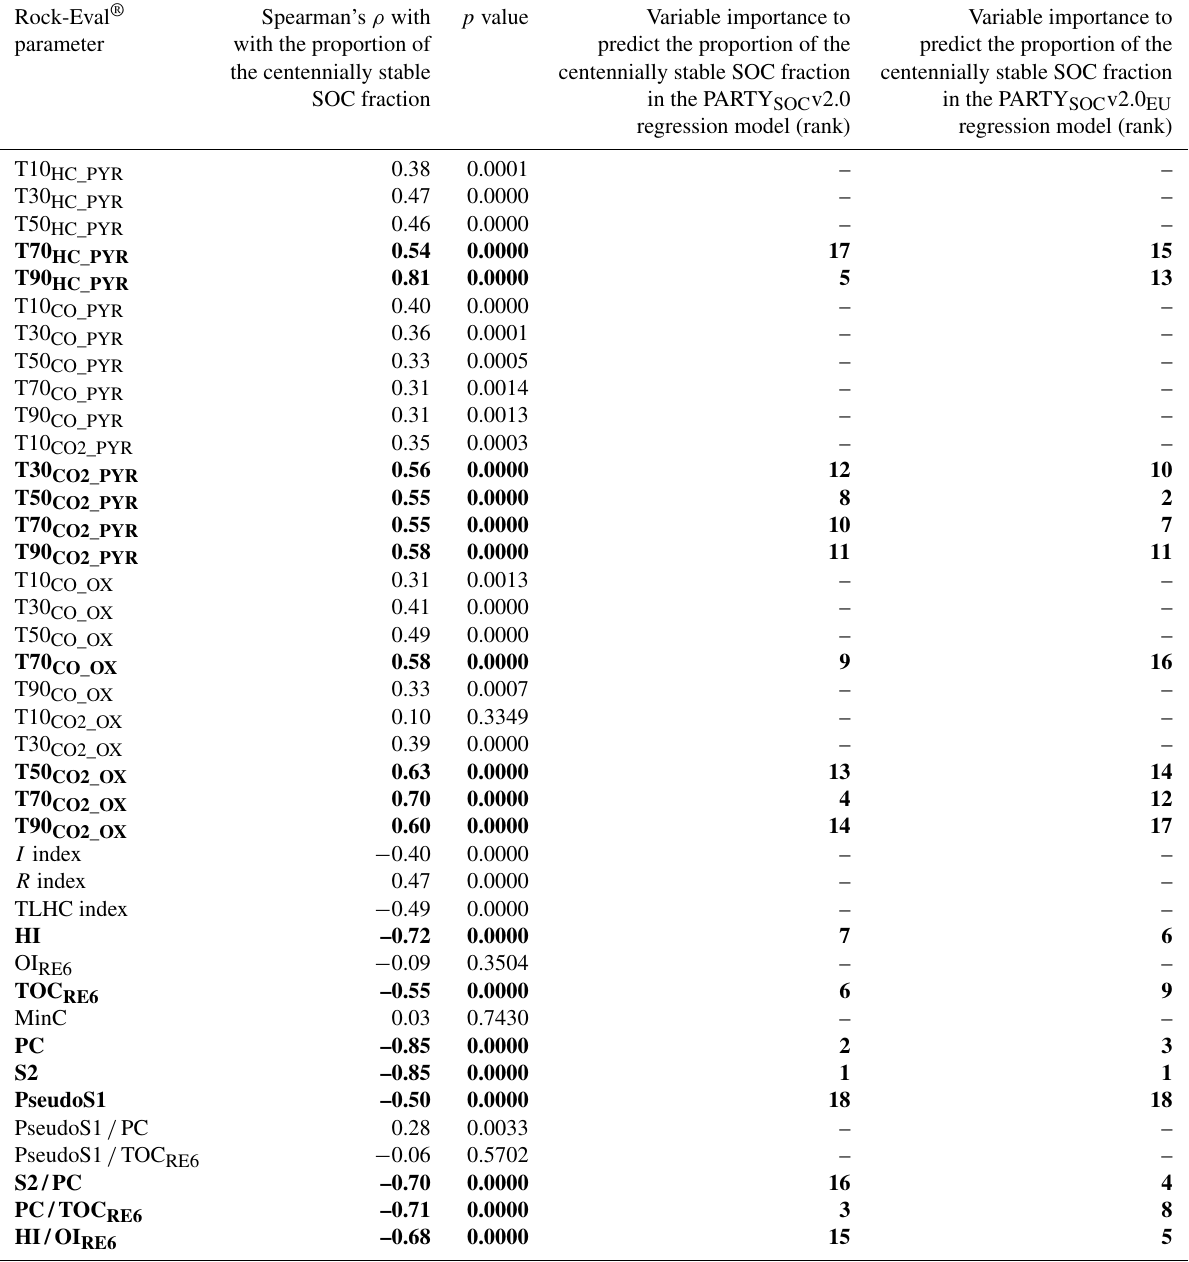
Table 2. Spearman’s rank correlation coefficient test between the 40 calculated Rock-Eval ® parameters and the proportion of the centennially stable organic carbon fraction in the reference topsoil sample set of the PARTY SOC v2.0 model ( n = 105), with the variable importance (rank- ing) of the 18 selected Rock-Eval ® parameters for predicting the proportion of the centennially stable SOC fraction in the PARTY SOC v2.0 and PARTY SOC v2.0 EU random forest regression models. See Sect. 2.2 for a description of the units of the 40 Rock-Eval ® parameters. The 18 Rock-Eval ® parameters retained as predictor variables for the second version of PARTY SOC are shown in bold. SOC: soil organic